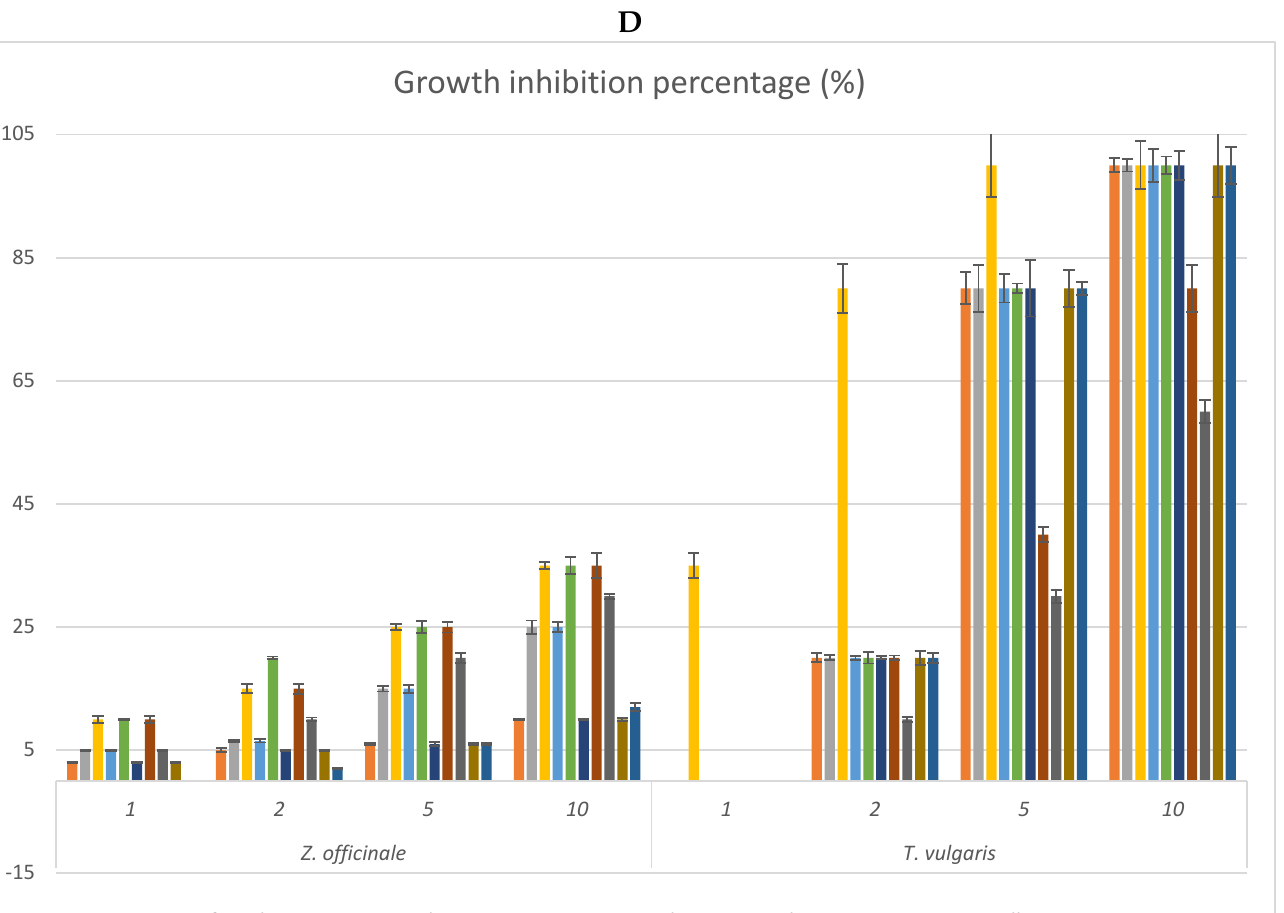
Figure 2. ( A - D ). Antimicrobial activities of the vapour phase of the EOs from studied species com- pared to that of commercial T. vulgaris . The bioactivity is expressed as growth inhibition percentage (%) checked at the doses of 1, 2, 5, and 10 μL. The bioactivity of the vapour phase of each EO is compared to that of T. vulgaris (positive control). ( A ). Growth inhibition percentage of the vapour phase of Curcuma longa ; ( B ). growth inhibition percentage of the vapour phase of Cymbopogon citratus ; ( C ). growth inhibition percentage of the vapour phase of Ocimum campechianum ; ( D ). growth inhibition percentage of the vapour phase of Zingiber officinale. Values are averages ± standard de- viation.